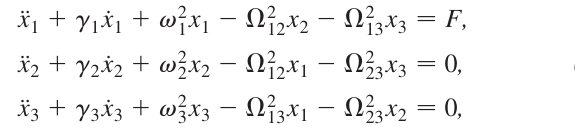
Fig. 4(b) we consider the case k k ¼ 0 : 17 mrad = nm , where ! 2 ¼ 7 : 33 mrad = nm and ! 3 ¼ 6 : 92 mrad = nm . From the